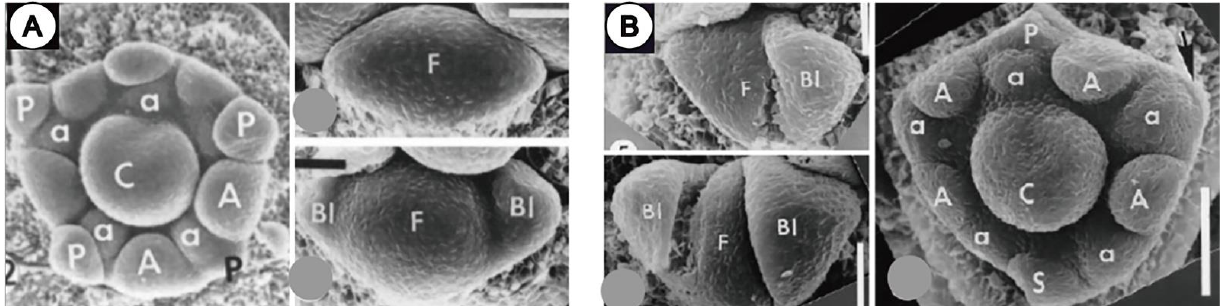
Figure 10. Inferred effect of bracteole compression on flower primordium in Fabaceae. ( A ) Devel- opment of Schotia brachypetala showing “circular” flower type with bracteoles that are relatively small and of loose contact with inner floral meristem, producing a mature flower with 5 petals and 10 stamens. ( B ) Development of Aphanocalyx djumaensis of “omega” type, with bracteoles relatively larger in size and in tight contact with floral meristem that develops usually only 1 abaxial sepal and 1 adaxial petal and 9 stamens (petal rudiment shown in arrow). Compression exerted by brac- teoles is noticed by pressure scars and squeezed form of the floral meristem in D, also evidencing lack of petal primordia in lateral abaxial positions of typical ‘‘keel’’ petals of Fabaceae. Abbreviation: F, floral meristem; Bl, bracteole; P, petal primordium; A, external anthers; a, internal anthers; S, sepal primordium; C, carpel. Scale bar in A, B = 50 µm. (( A ) reproduced from Tucker, 2001; ( B ) from Tucker, 2000 with permission). [58,59].